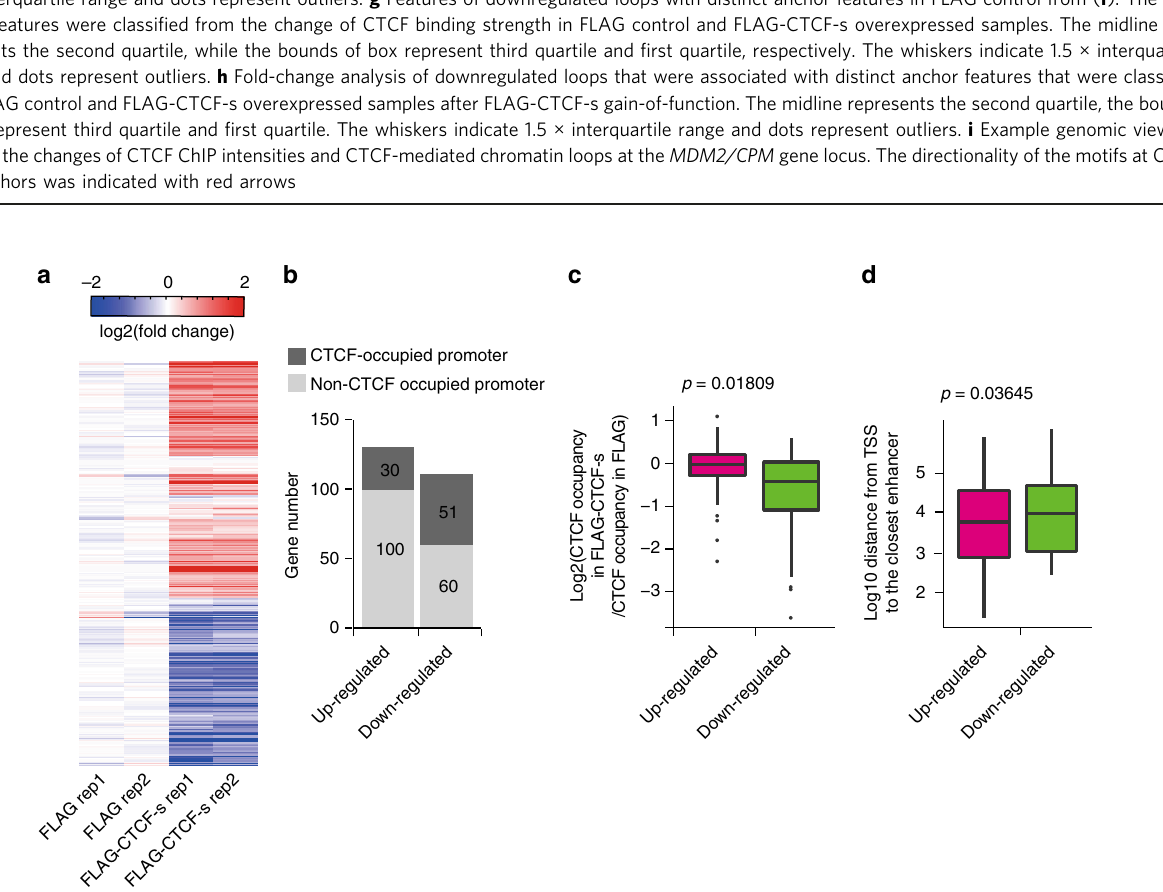
Fig. 4 CTCF-s/CTCF competition and transcriptional regulation. a Hierarchical clustering of differentially expressed (DE) gene pro fi les after overexpression of FLAG-CTCF-s in HeLa-S3 cells. Fold-change was relative to the mean of the FLAG control. b Analysis of CTCF binding at promoters of DE genes, from panel ( a ). c CTCF-s downregulated genes tended to have decreased CTCF binding at their promoter regions. The center line represents the second quartile, the bounds of box represent third quartile and fi rst quartile. The whiskers indicate 1.5 × interquartile range and dots represent outliers. d Upregulated genes by CTCF-s tended to have enhancers that were closer to the TSS than downregulated genes. The center line represents the second quartile, the bounds of box represent third quartile and fi rst quartile. The whiskers indicate 1.5 × interquartile range and dots represent outliers. The statistical signi fi cance for the boxplots in ( c , d ) was assessed by Wilcoxon rank sum